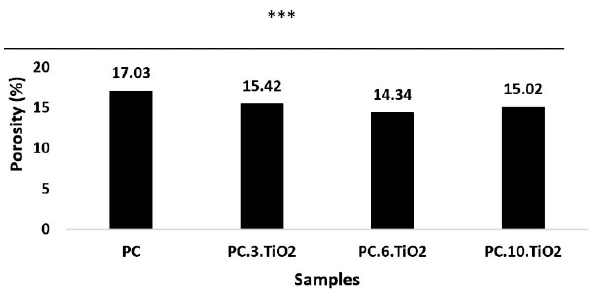
Figure 10 Average samples results of porosity tests. *** Statistically significant difference by the Tukey test p <0.001.